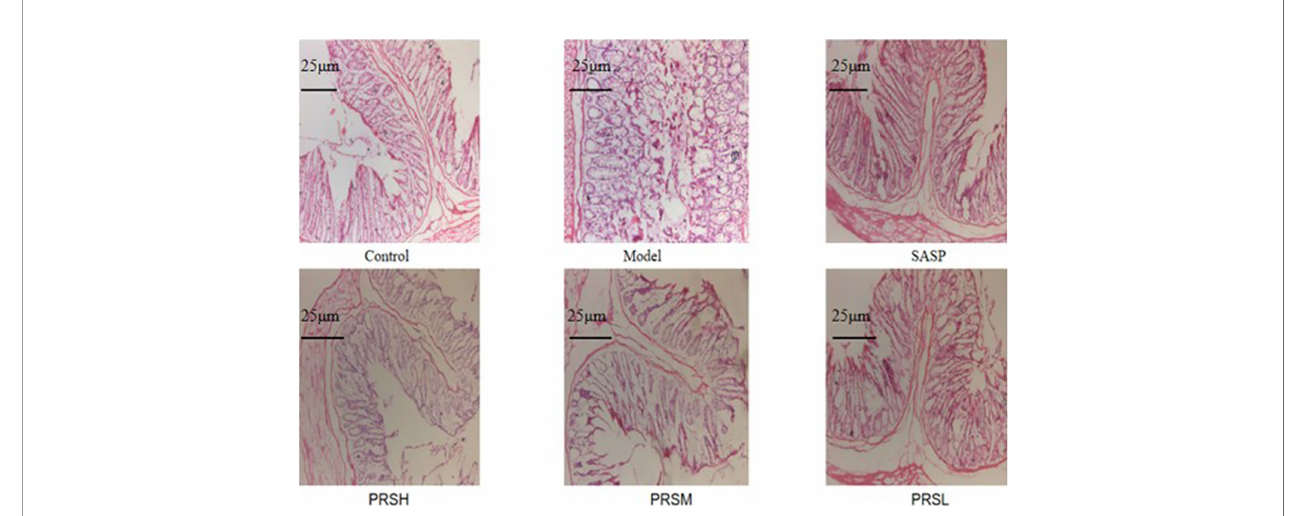
FIGURE 2 | Histopathological changes were improved by PRS saponins. The colons of each group were processed for histological evaluation (H&E staining 100×). The scale bar is 25 m m.